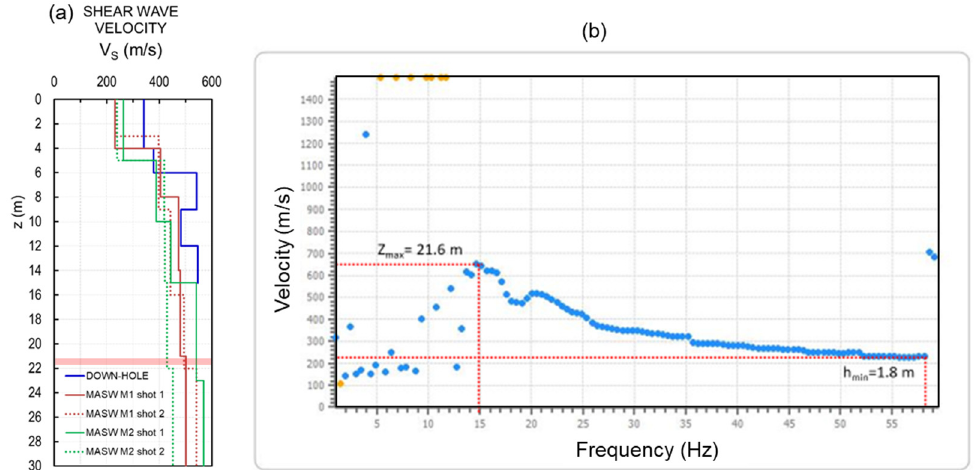
Figure 12. ( a ) Comparison of V S obtained from down-hole (borehole BH2) and MASW (M1, M2); ( b ) dispersion curve with identification of the maximum depth, z max , for which the MASW measurements are reliable.